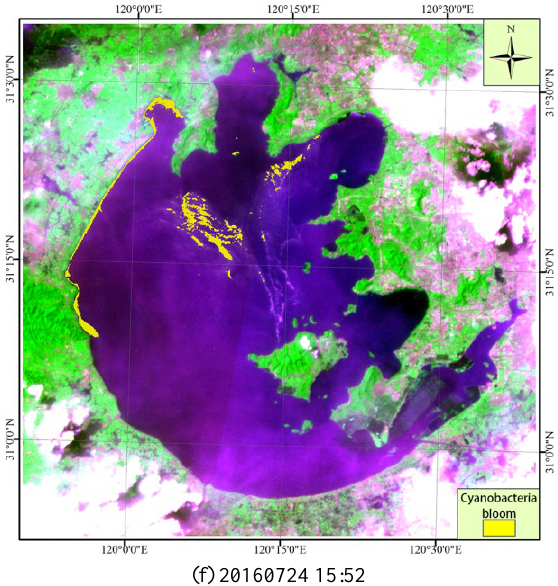
Figure 1. Cyanobacteria bloom identification results using